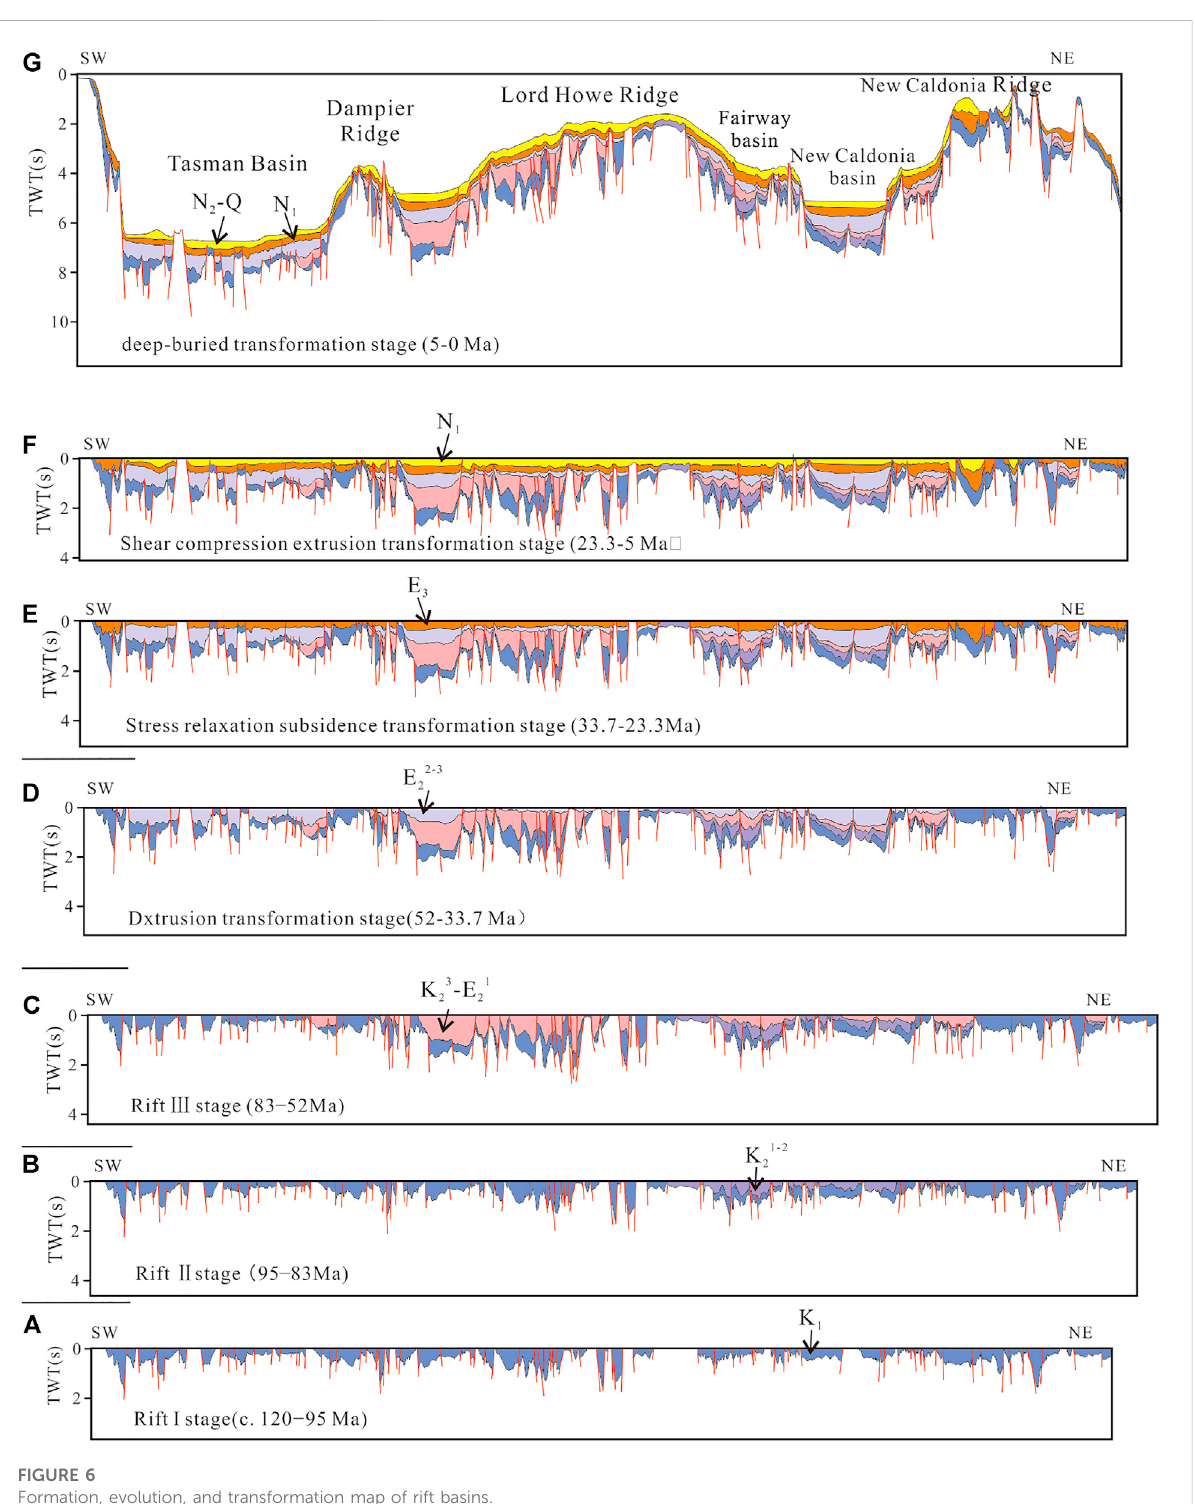
FIGURE 6 Formation, evolution, and transformation map of rift